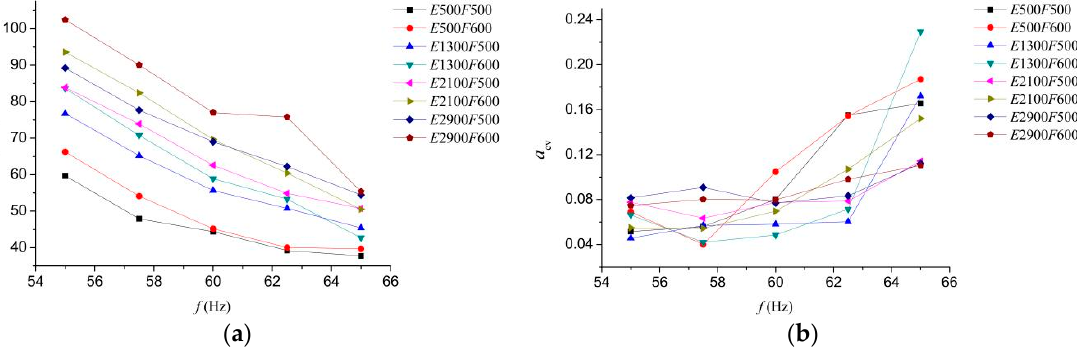
Figure 7. The curves of A and a cv changing with excitation frequency. ( a ) The curve of A changing with excitation frequency. ( b ) The curve of a cv changing with excitation frequency.